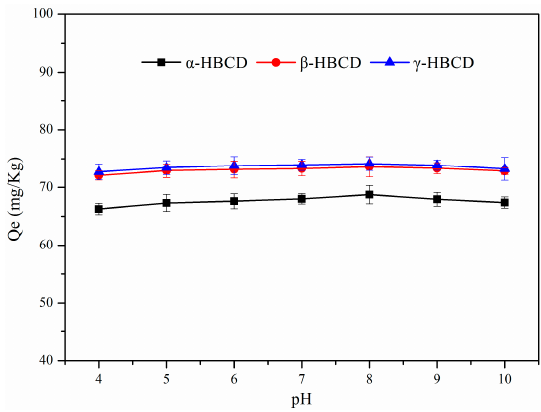
Figure 4. E ff ects of pH on HBCDs sorption in the Figure 4. Effects of pH on HBCDs sorption in the sediment.